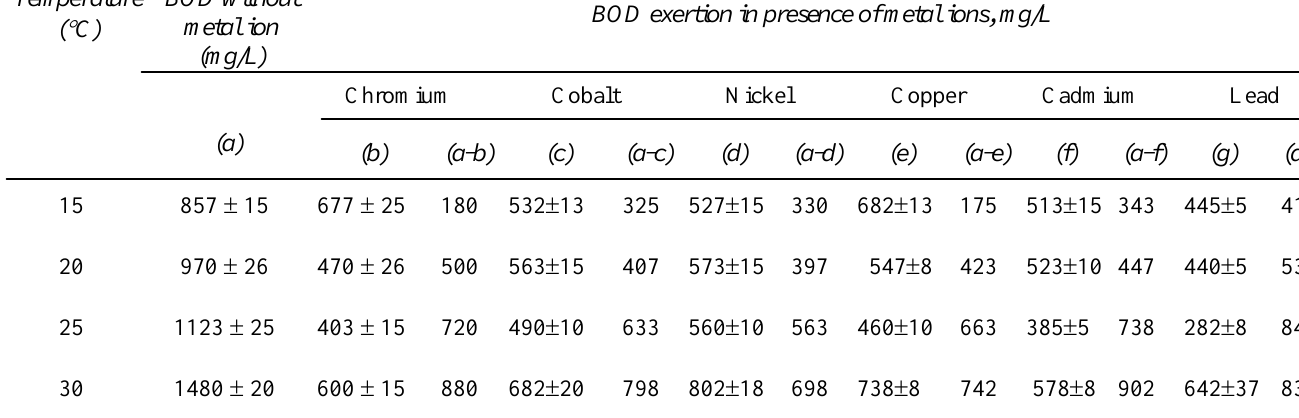
Table 1 : BOD exertion as a function of temperature in presence of different metal ions BOD without